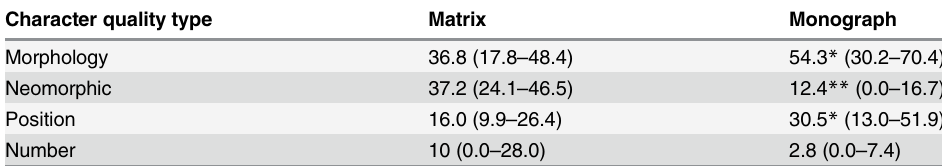
Table 6. Average percent of character quality types (range in parentheses) for matrix publications (combined) and monographs (combined). t-test * p < 0.05; ** p < 0.001. Breakdown of types per publication shown in S2